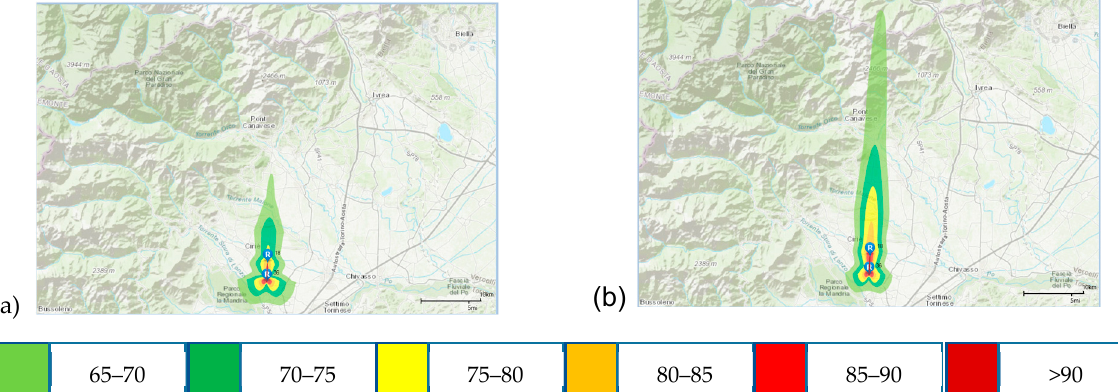
Figure 45. Graphical representation of equal loudness contours for the conventional ( a ) and hybrid ( b ) configurations, in terms of L AE (dB-A), for a standard runway-36 take-off.